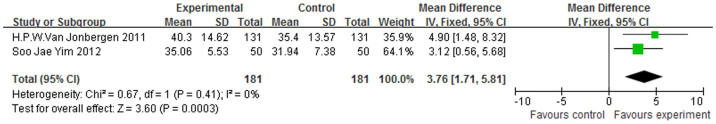
Forest plot of WOMAC between the circumpatellarelectrocautery and non-electrocautery groups.